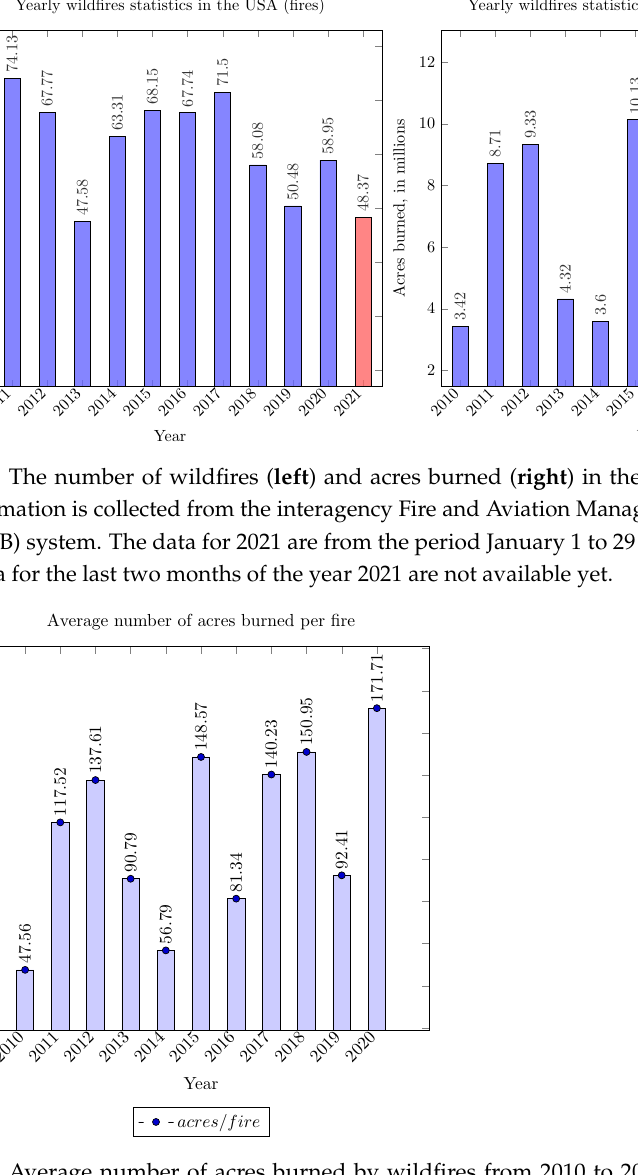
Figure 2. Average number of acres burned by wildfires from 2010 to 2020. The number of fires decreased, but the effect of those fires is more devastating—more acres are burned by fewer